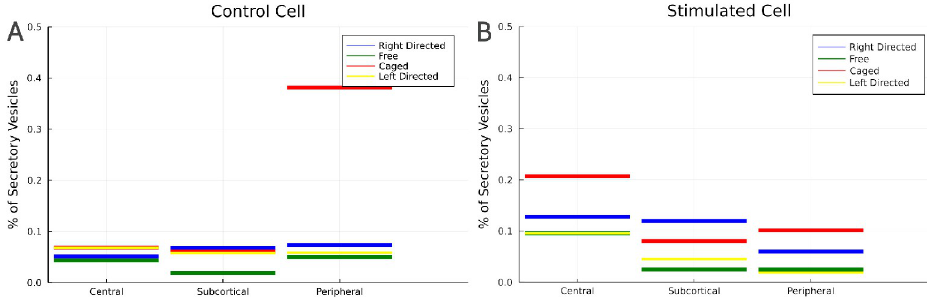
Fig 6. Simulated steady state probability distributions of vesicles in control (A) and upon stimulation (B), both normalised so they admit a probabilistic interpretation.